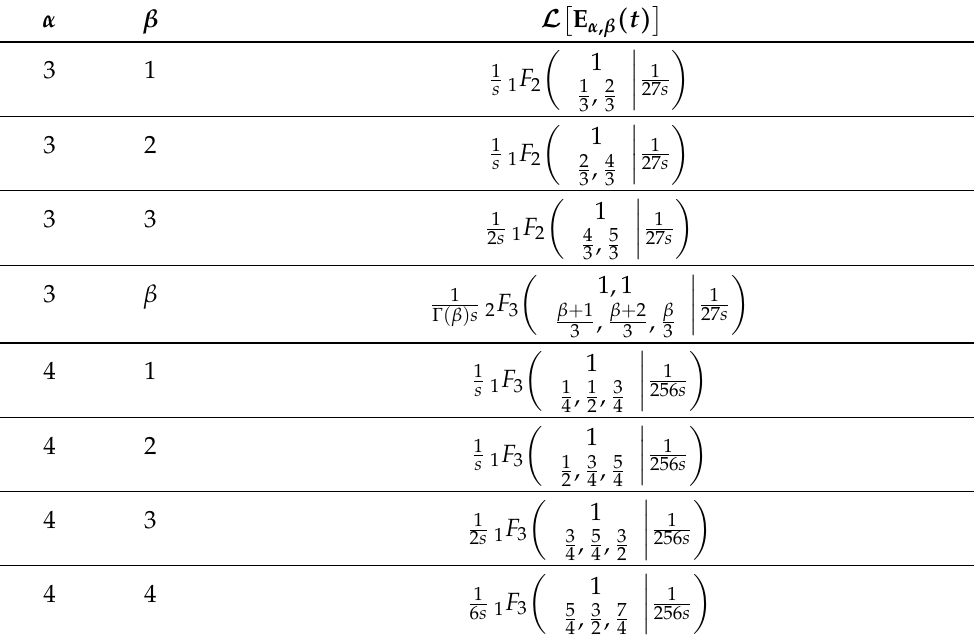
Table A4. The Laplace transforms Mittag-Leffler functions derived for some values of parameters α and β by using